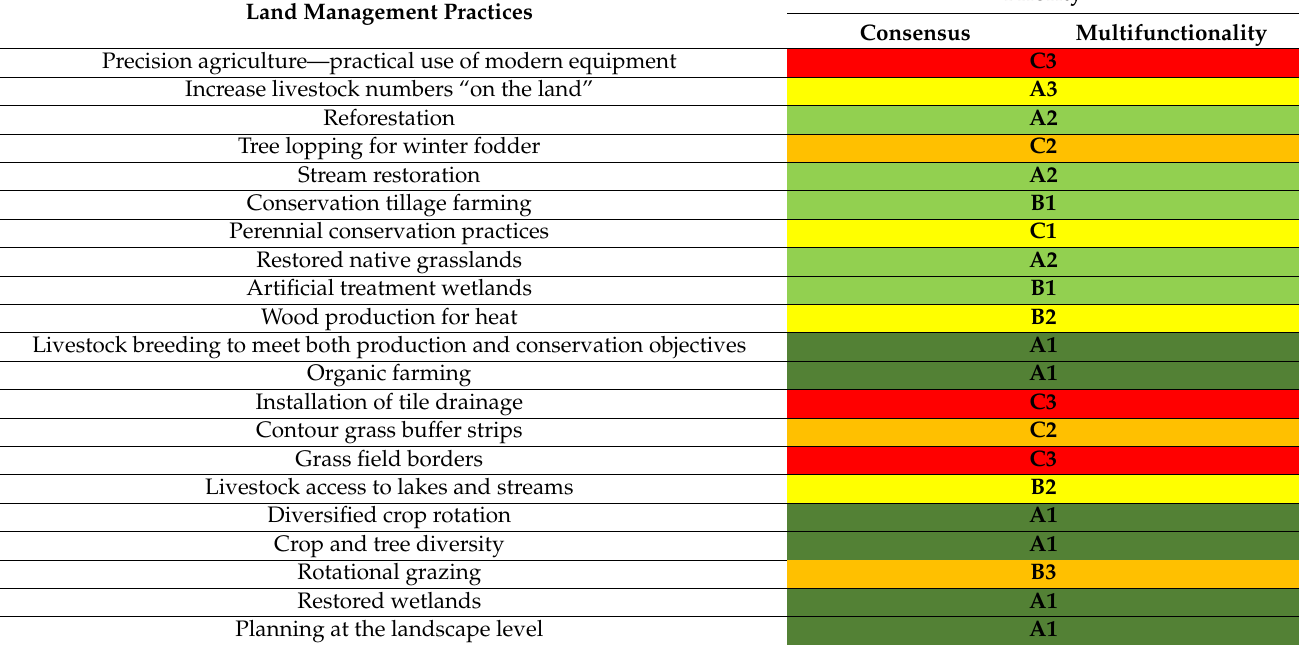
Table 3. Ranking of land management practices in Prespa Lakes watershed. Five color-coded categories define priorities: (A1, dark green) very high priority, (A2 and B1, light green) high priority, (A3, B2, and C1, yellow) moderate priority, (B3 and C2, orange) low priority, and (C3, red) very low